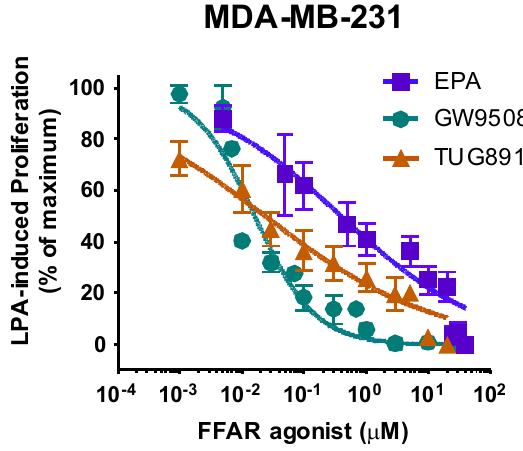
Figure 6. Dose ‐ response for effects of FFAR agonists on breast cancer cell proliferation. Serum ‐ starved MDA ‐ MB ‐ 231 cells were incubated for 48 h with and without 10 μ M LPA in the absence and presence of the indicated concentrations of EPA, GW9508, and TUG ‐ 891. The number of cells achieved in response to LPA alone was defined as 100% response; the number of cells present in the absence of LPA was defined as 0% response. Each point represents mean ± SEM ( n ≥ 4 for values obtained from at least two experiments, each performed with two separate replicate wells of cells for each experimental condition.